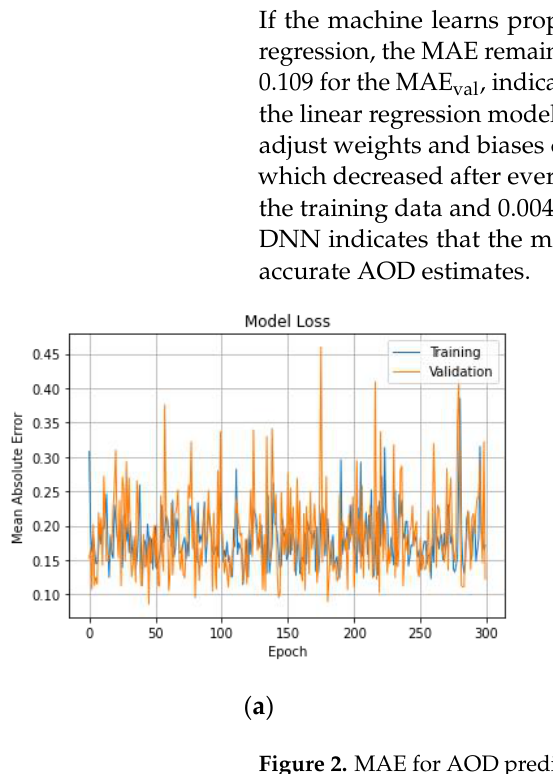
Figure 3. MAE for epoch ( a ) -BBE; ( b ) +BBE.